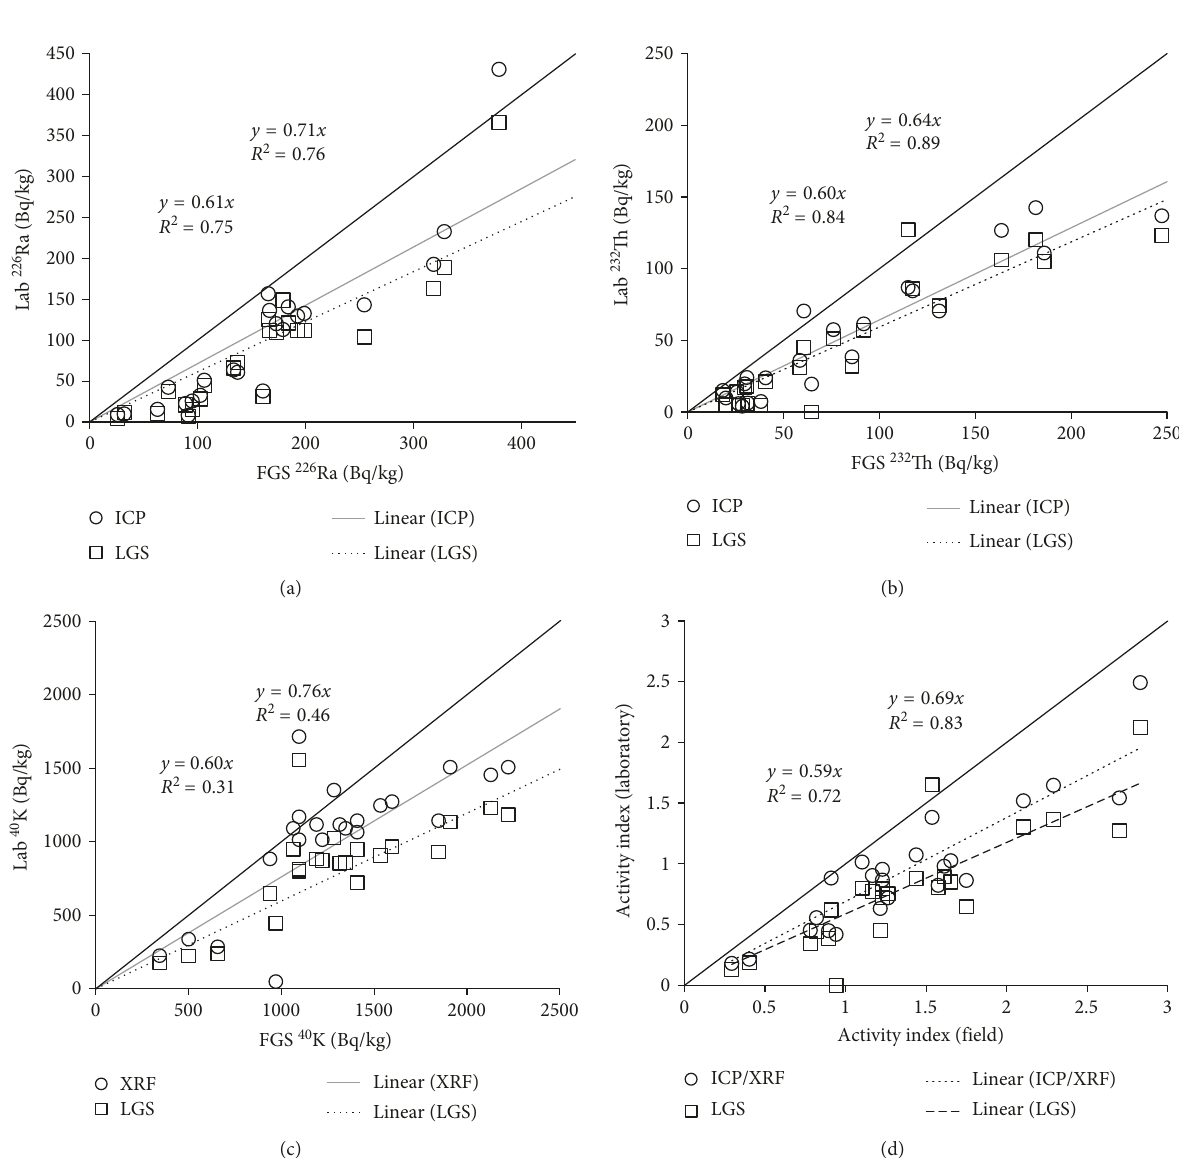
Figure 4: Plots of the results from laboratory analyses (ICP, XRF, and LGS: laboratory gamma spectrometry) against field estimations: (a) 226 Ra activity concentration; (b) 232 Th activity concentration; (c) 40 K activity concentration; (d) activity concentration index calculated from the isotopes estimations. Table 1: Spearman correlation coefficients between the calculated values of the concentration activity index ( I ) from different pro- cedures for estimation of isotopes specific activity and related p values. N R p